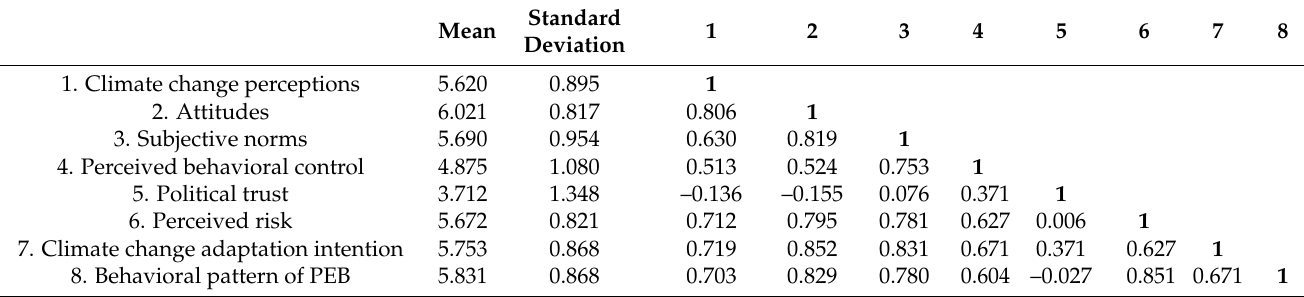
Table 3. The correlation matrix of studied constructs.